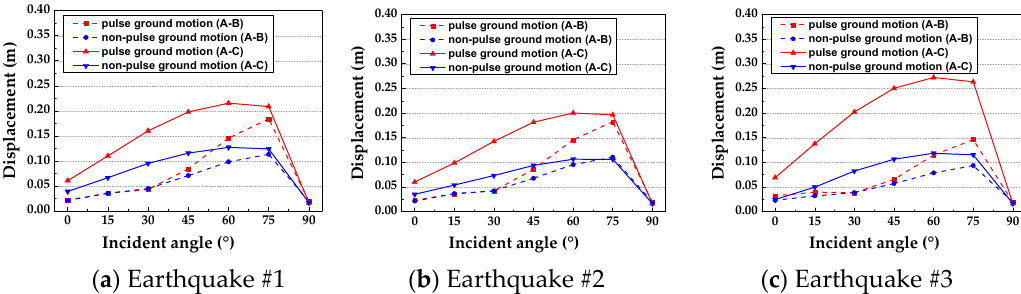
Figure 11. The maximum absolute value of the relative horizontal displacements (under different input angles).